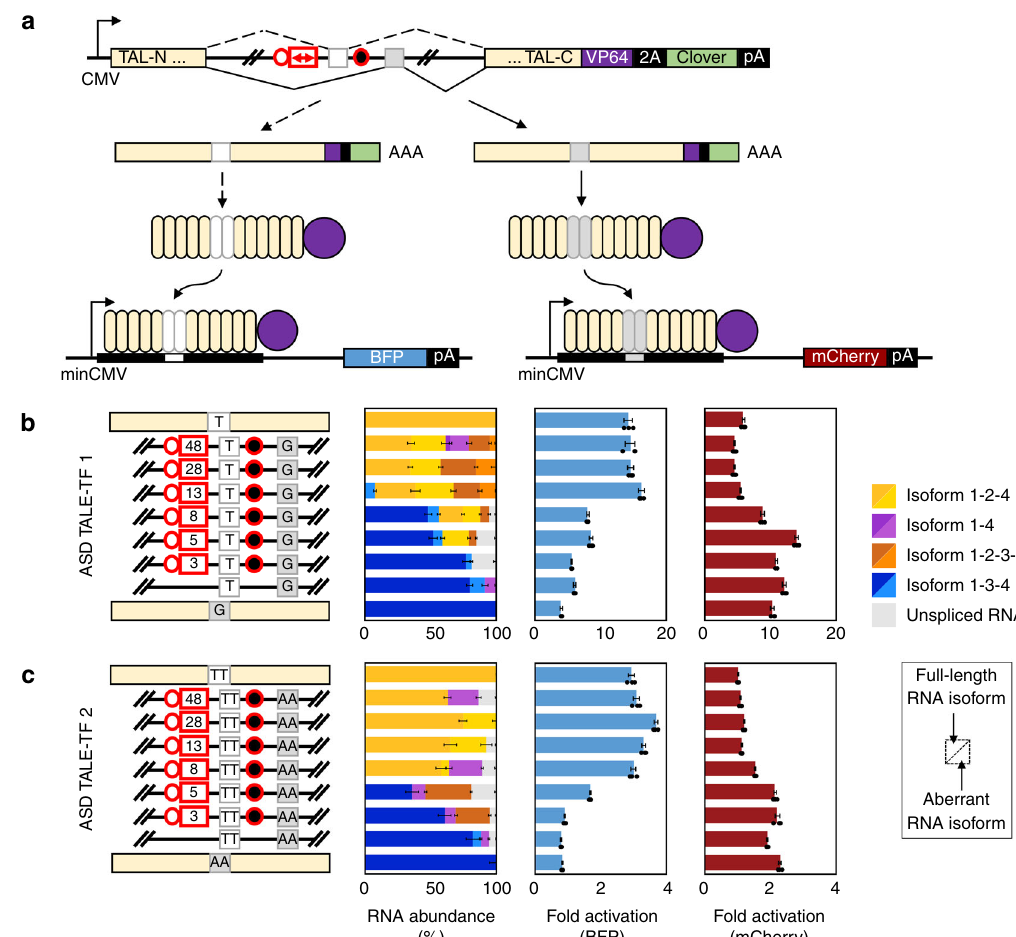
Fig. 6 Spliced transcription factors generate mutually exclusive isoforms for controlled gene activation from two distinct promoters. a Schematic illustrating the activation of two fl uorescent proteins from a single MEAS event, where isoform 1-2-4 activates BFP reporter expression and isoform 1-3-4 activates mCherry reporter expression. Devices contain mutated BP elements for exons 2 and 3 (circles with red outlines) and modi fi ed exon 2 PPT elements (white rectangle with red outline representing PPT sequence lengths in nucleotides). b ASD TALE-TF 1 devices built from a modi fi ed intron framework that encode RVD NG (target site T) in exon 2 and RVD NN (target site G) in exon 3. c ASD TALE-TF 2 devices built from a modi fi ed intron framework that encode RVDs NG NG (target site TT) in exon 2 and RVDs NI NI (target site AA) in exon 3. Relative RNA isoform abundances were characterized using long-read sequencing. Error bars in the RNA isoform data represent ±1 standard deviation from biological triplicates. Blue represents RNA isoform 1-3-4 and its derivatives; yellow represents RNA isoform 1-2-4 and its derivatives; orange represents RNA isoform 1-2-3-4 and its derivatives; purple represents RNA isoform 1-4 and its derivatives; and gray represents unspliced transcript. The fold activation was determined via fl ow cytometry analysis of BFP and mCherry fl uorescence in transfected HEK-293T cells, and calculated as the ratio of the median BFP or mCherry fl uorescence intensity of cells co- transfected with and without the speci fi ed ASD TALE-TF. Fold activations from biological triplicates were averaged and reported within an error range of ±1 standard deviation. Source data are provided as a Source Data fi